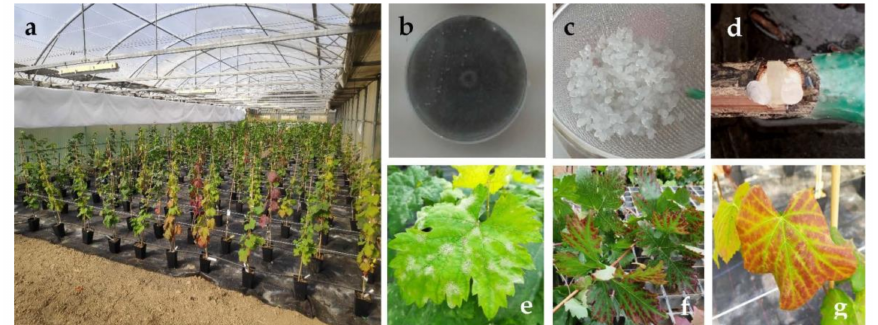
Figure 1. Bioassays in the greenhouse with grafted grapevine plants. ( a ): Bioassay overview; ( b ): fresh culture of Neofussicoccum parvum on PDA plate; ( c ): calcium alginate beads including control product; ( d ): inoculation method; ( e ): leaves infected with powdery mildew; ( f , g ): presence of foliar symptoms in grapevine